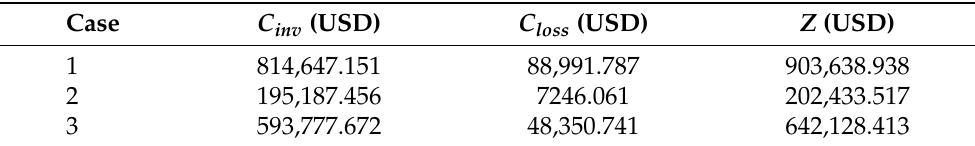
Table 17. Investment and operating costs found with the application of the GNDO to the three-phase version of the IEEE 33-bus grid for each operative